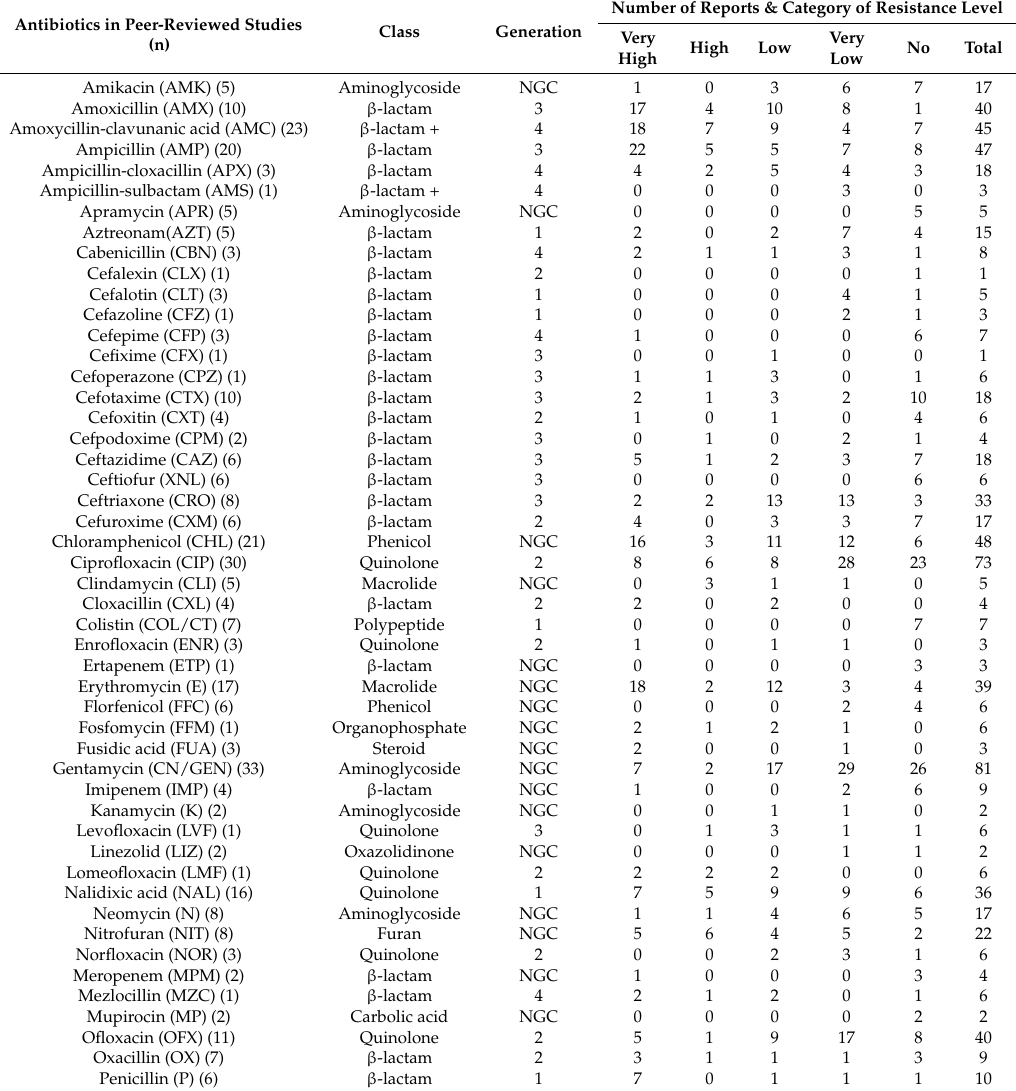
Table 3. List of antibiotics used and the number of reports of each antimicrobial resistance. Antibiotics in Peer-Reviewed Studies